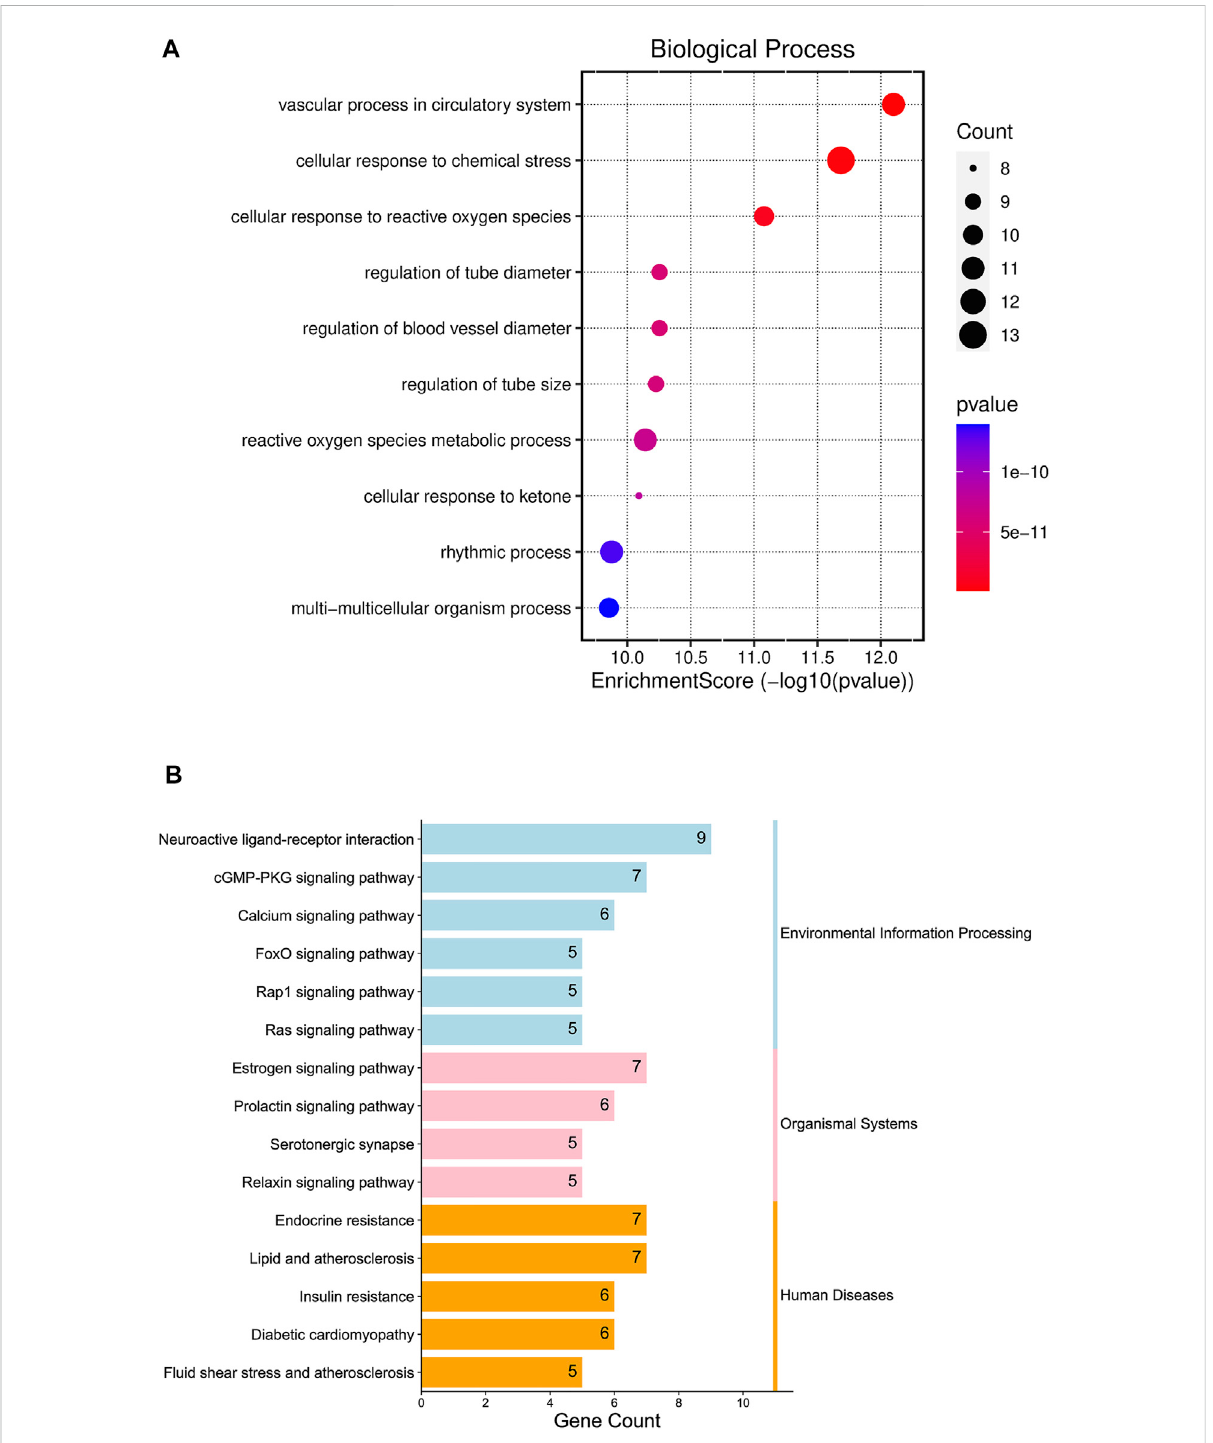
FIGURE 5 Gene Ontology (GO) enrichment analysis diagram (A) ; Kyoto Encyclopedia of Genes and Genomes (KEGG) Enrichment Pathway Bar Chart (B)